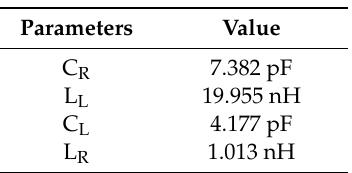
Figure 10. 3D view of the CRLH transmission line unit cell. Table 2. Parameters of the CRLH TL unit cell.